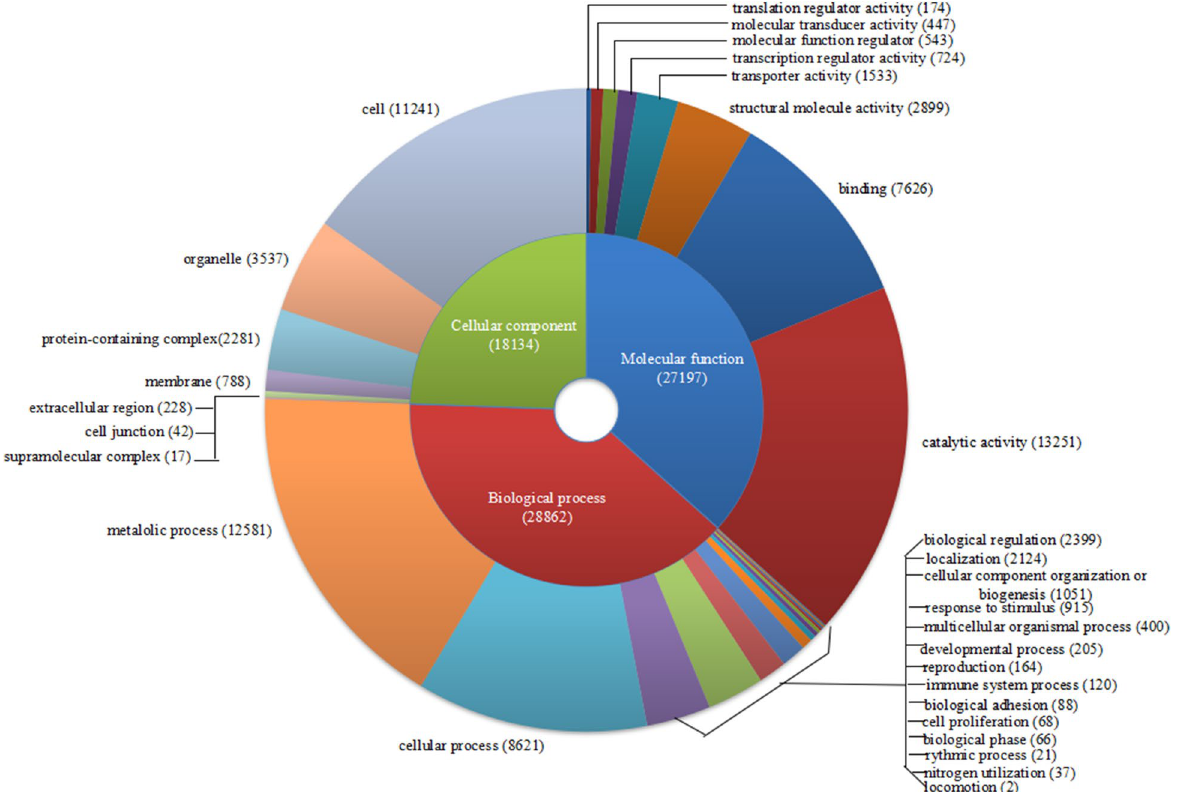
Fig. 1 Gene ontology category distribution of MAG proteins in Spodoptera